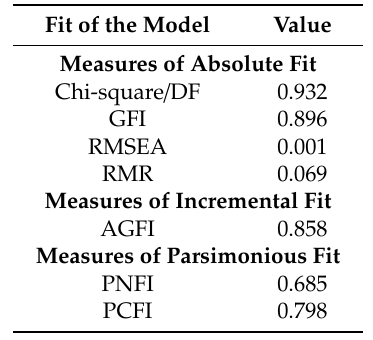
Table 4. The goodness of fit model.